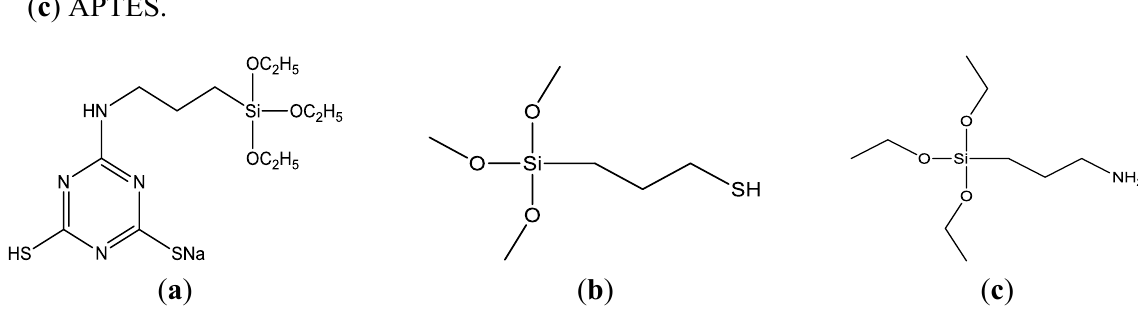
Figure 7. Structural formulas of TES, MPTMS and APTES. ( a ) TES; ( b ) MPTMS; ( c )